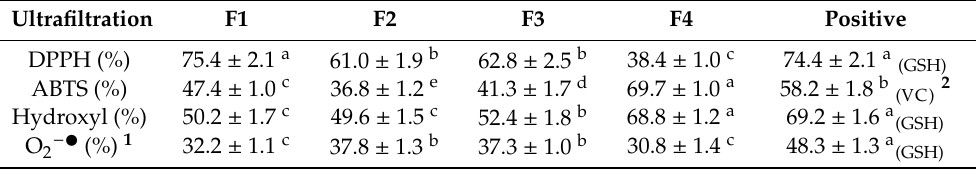
Table 2. The antioxidant activity of the ultrafiltration fractions (F1–F4).